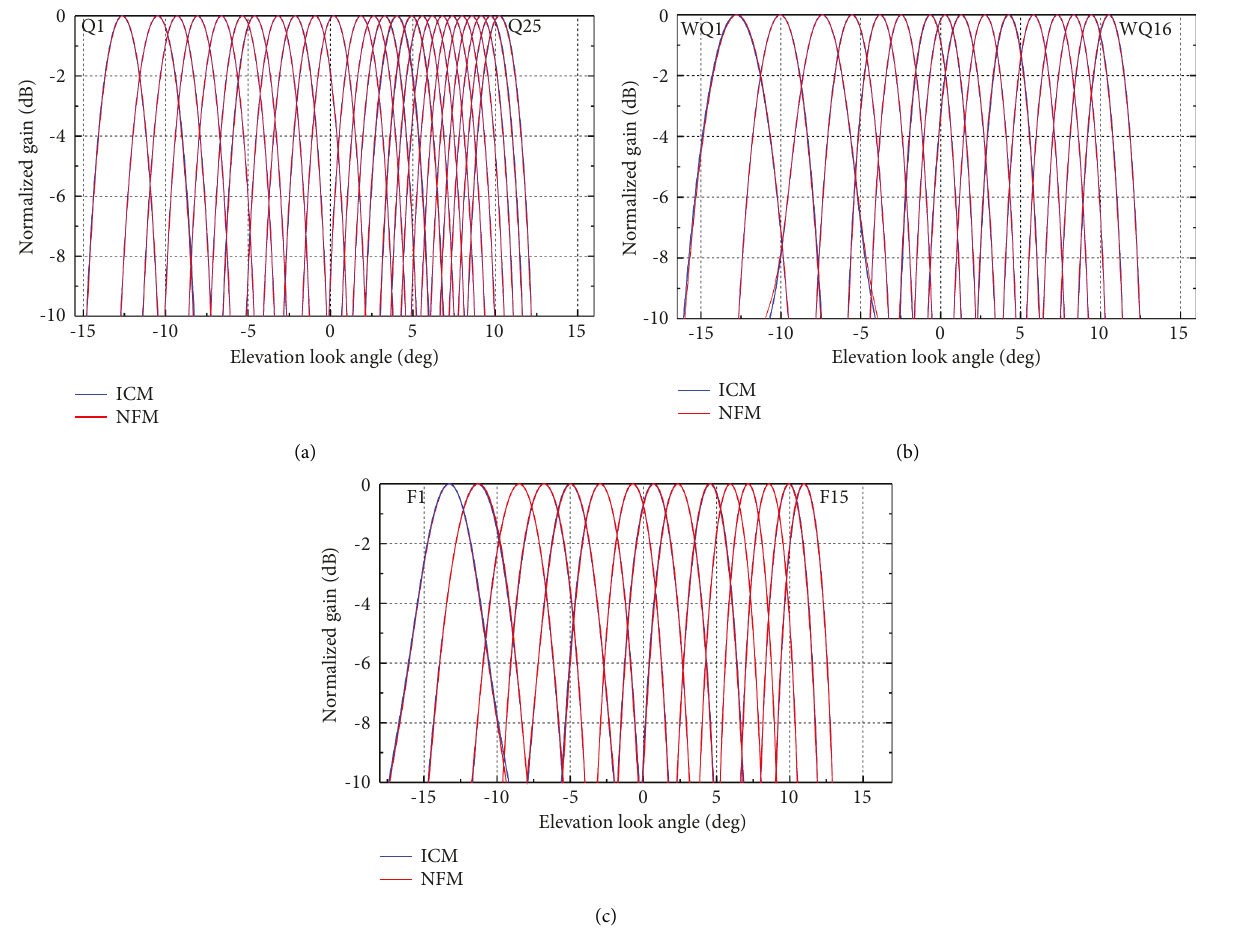
Figure 9: Elevation pattern comparison of the internal calibration method (ICM) to the near-field method (NFM) for typical observing modes. (a) Quad-pol stripmap mode (Q mode). (b) Wide quad-pol stripmap mode (WQ mode). (c) Fine stripmap mode (F